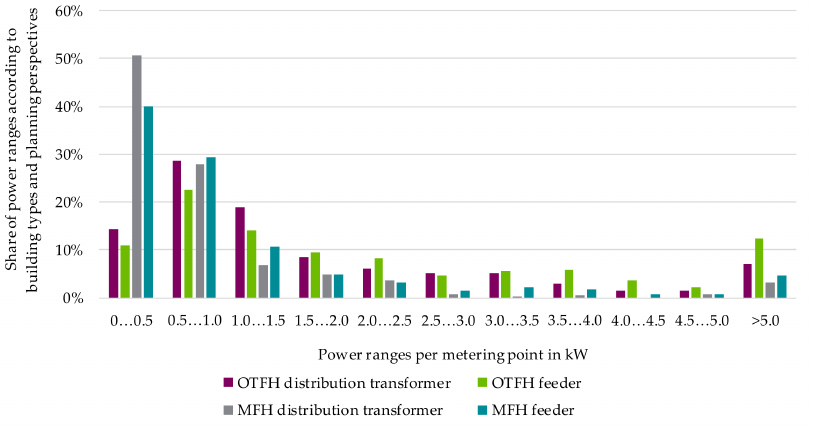
Figure 26. Performance ranges of conventional loads per building type and planning perspective based on